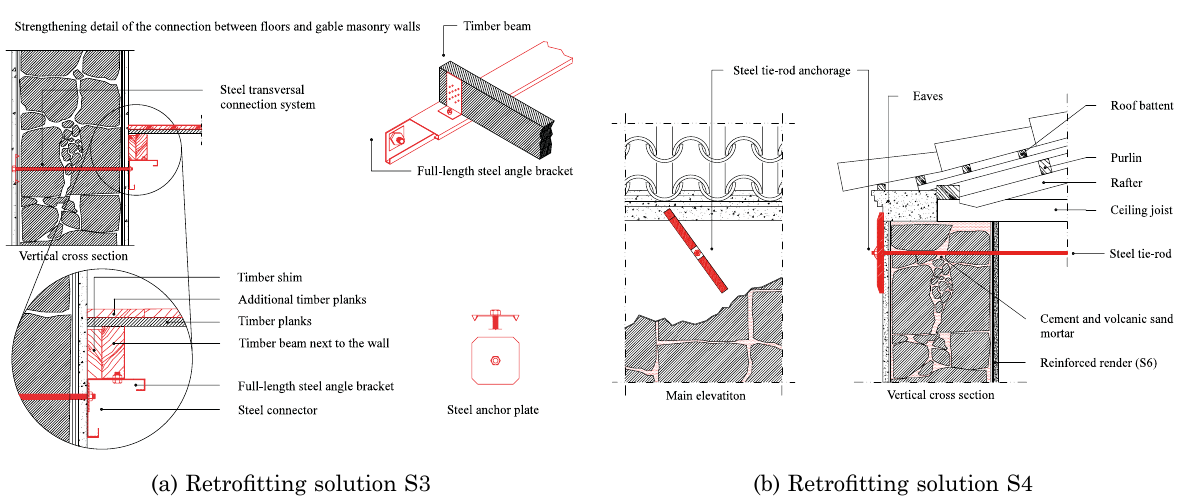
fig. 2. details of retrofitting solutions S3 (a) and S4 (b) of package rP1, adapted from Costa (2006)